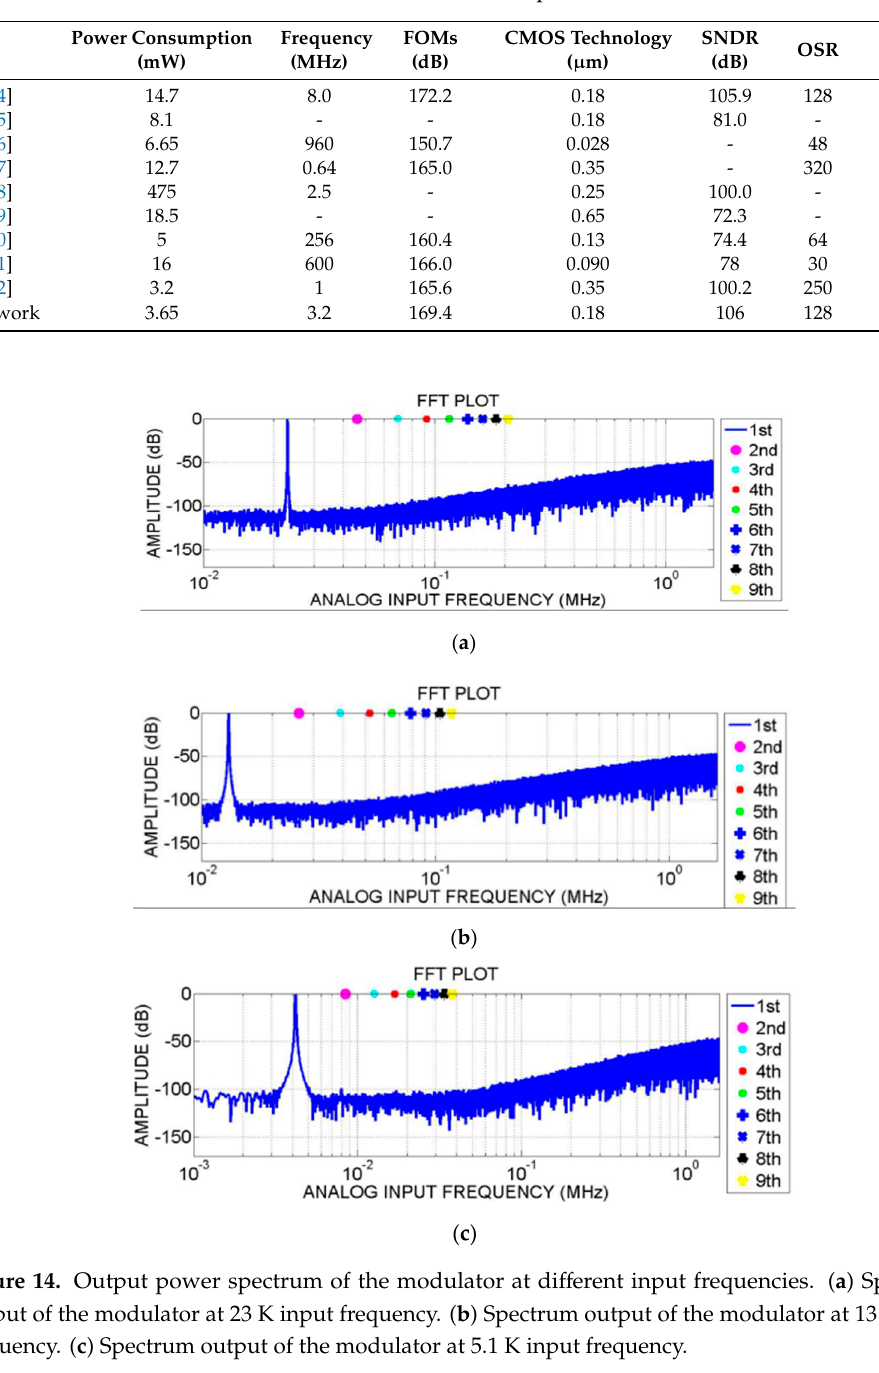
Figure 15. Measured relationship between input signal frequency and signal to noise distortion ratio (SNDR). 9. Conclusions Employing a second-order 5-bit quantization structure, a Σ - Δ modulator with low power consumption and a high-resolution modulator scheme was proposed for analogue-to-digital converters. Through optimizing the circuit structure, a reusable quantizer sigma-delta modulator based on the SAR structure was presented. Under the condition of a 128 oversampling rate, it demonstrates a resolution of 16 bits, power consumption of 3.654 mW and FOMs of 169.4 dB for 0 to 25 kHz analogue signals, showing it has higher data conversion efficiency and a higher optimal value. These results confirmed that the modulator of this structure meets the requirements of low power consumption and high precision for audio applications. The whole modulator was realized by a SMIC single-layer polysilicon six-layer metal 180 nm CMOS process where the working power supply voltage was 1.8 V. In comparison with other reported modulators realized by a 180 nm CMOS process, the proposed architecture offers several advantages and is far superior retrospectively with lower power consumption. Author Contributions: Conceptualization, S.A. and R.Y.; methodology, S.A.; software, Y.M.; validation, S.X., R.A.A.-A.; formal analysis, C.H.S. and A.G; investigation, C.N.; resources, Y.M.; data curation, C.H.S. and A.G.; writing—original draft preparation, S.A. and S.X.; writing—review and editing, C.N., R.A.A.-A., A.G., and C.H.S.; visualization, A.G.; supervision, R.Y.; project administration, A.G.; funding acquisition, R.Y. All authors have read and agreed to the published version of the manuscript. Funding: This research received no external funding. Acknowledgments: This research was funded by the National Natural Science Foundation of China (NO.61774054).